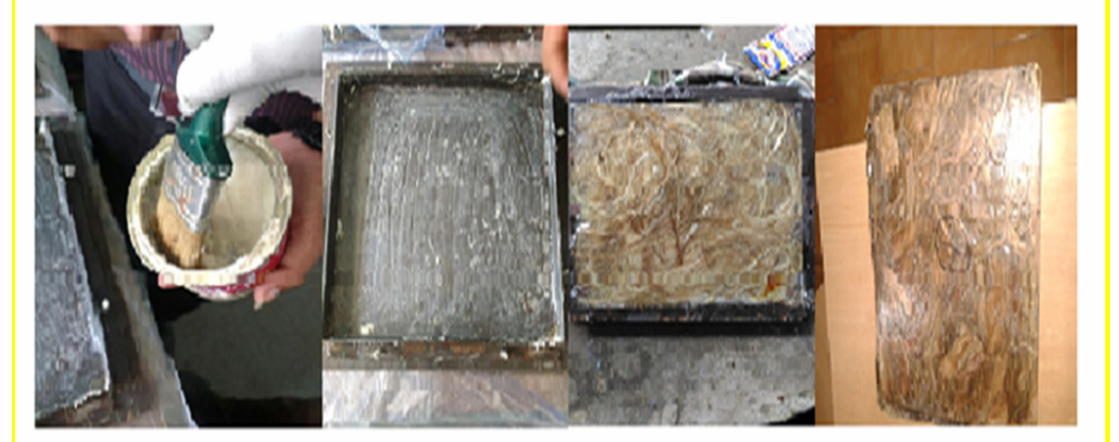
Figure 4. The fabrication process of the hybrid epoxy